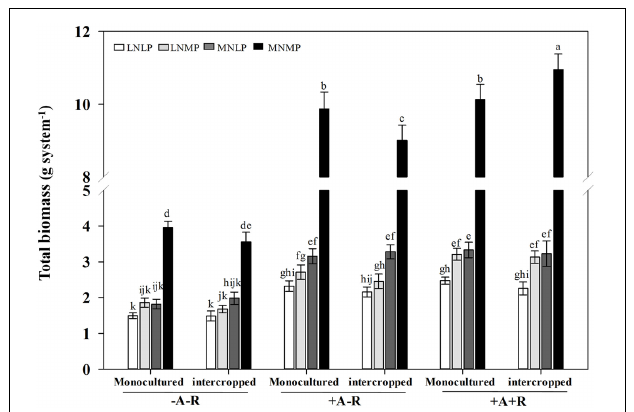
FIGURE 1 | Effects of inoculation with AMF and rhizobia on total biomasses of soybean and maize in a greenhouse experiment. Data in the figure are the mean of four replicates with standard error. Different letters indicate significant differences among inoculation treatments (Duncan’s multiple range test, P < 0.05). − A − R: no inoculation; + A − R: sole inoculation with AMF; + A + R: co-inoculation with AMF and rhizobia. LNLP, low N and P; LNMP, low N and moderate P; MNLP, moderate N and low P; MNMP, moderate N and P.